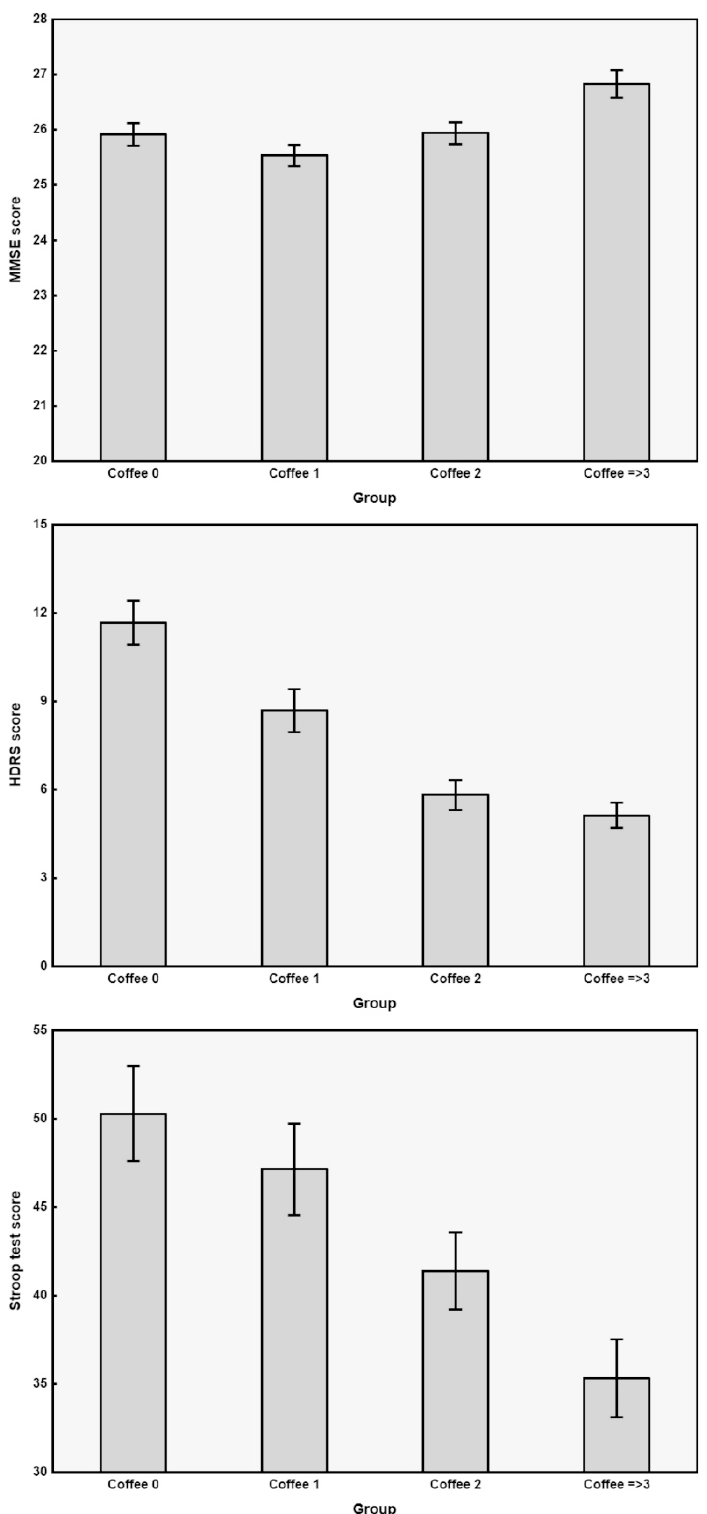
Figure 1. Bar graphs of continuous outcome variables obtained from the four groups of subjects and showing significant differences in Table 1. Data are shown as means (columns) and standard error (wishers). Coffee 0 = non-coffee drinkers; Coffee 1 = consumers of 1 cup daily; Coffee 2 = consumers of 2 cups daily; Coffee ≥ 3 = consumers of 3 or more cups daily; MMSE = Mini Mental State Examination; HDRS = 17-item Hamilton Depression Rating Scale; Stroop T = Stroop Colour-Word Interference Test.